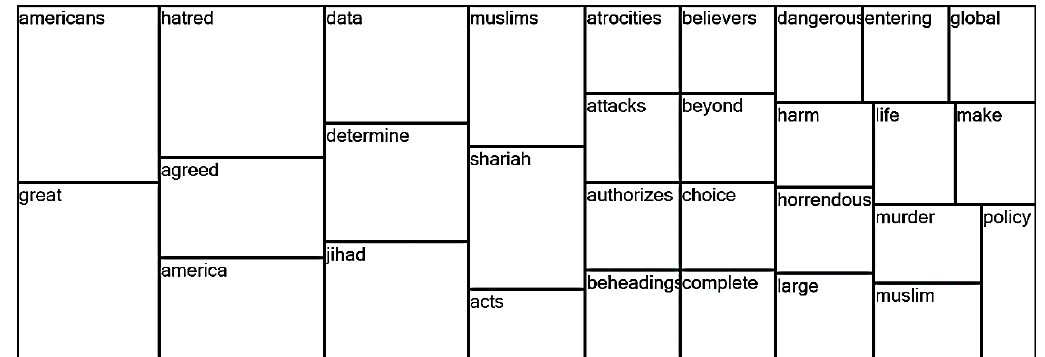
Figure 2. Tree-Map of frequently used terms used in the Statement